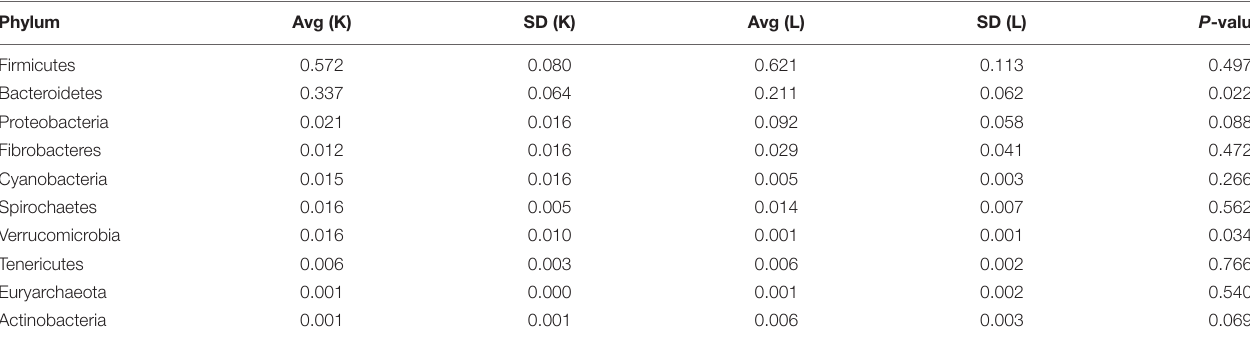
FIGURE 7 | Non-metric multidimensional scaling (NMDS) and principal component analysis (PCA) of bacterial community structures. Each symbol represents the gut microbiota of an individual and the different colors represent the different groups. K, low-altitude mouflon; L, high-altitude mouflon; M, low-altitude blue sheep; N, high-altitude blue sheep. TABLE 5 | Relative abundance of the top 10 most abundant bacterial phyla in the European mouflon sheep.